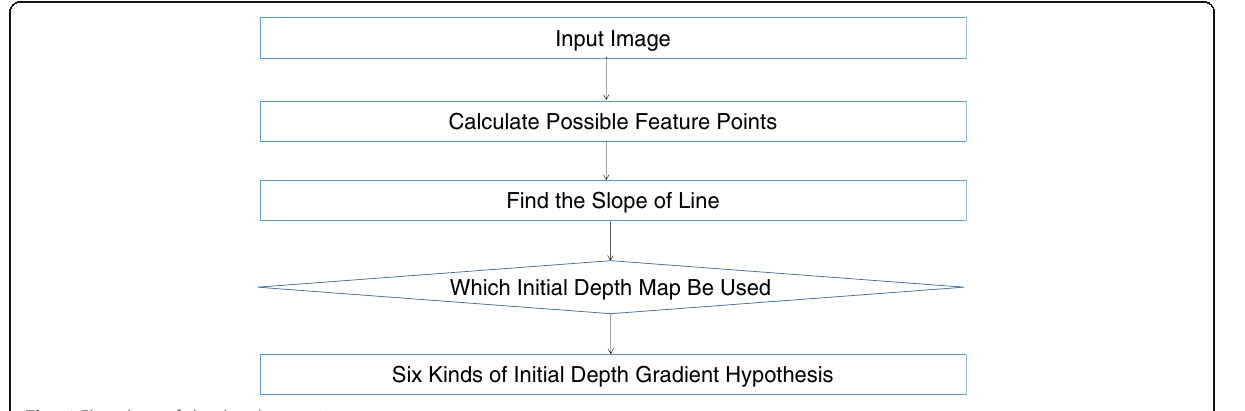
Fig. 6 Flowchart of depth values